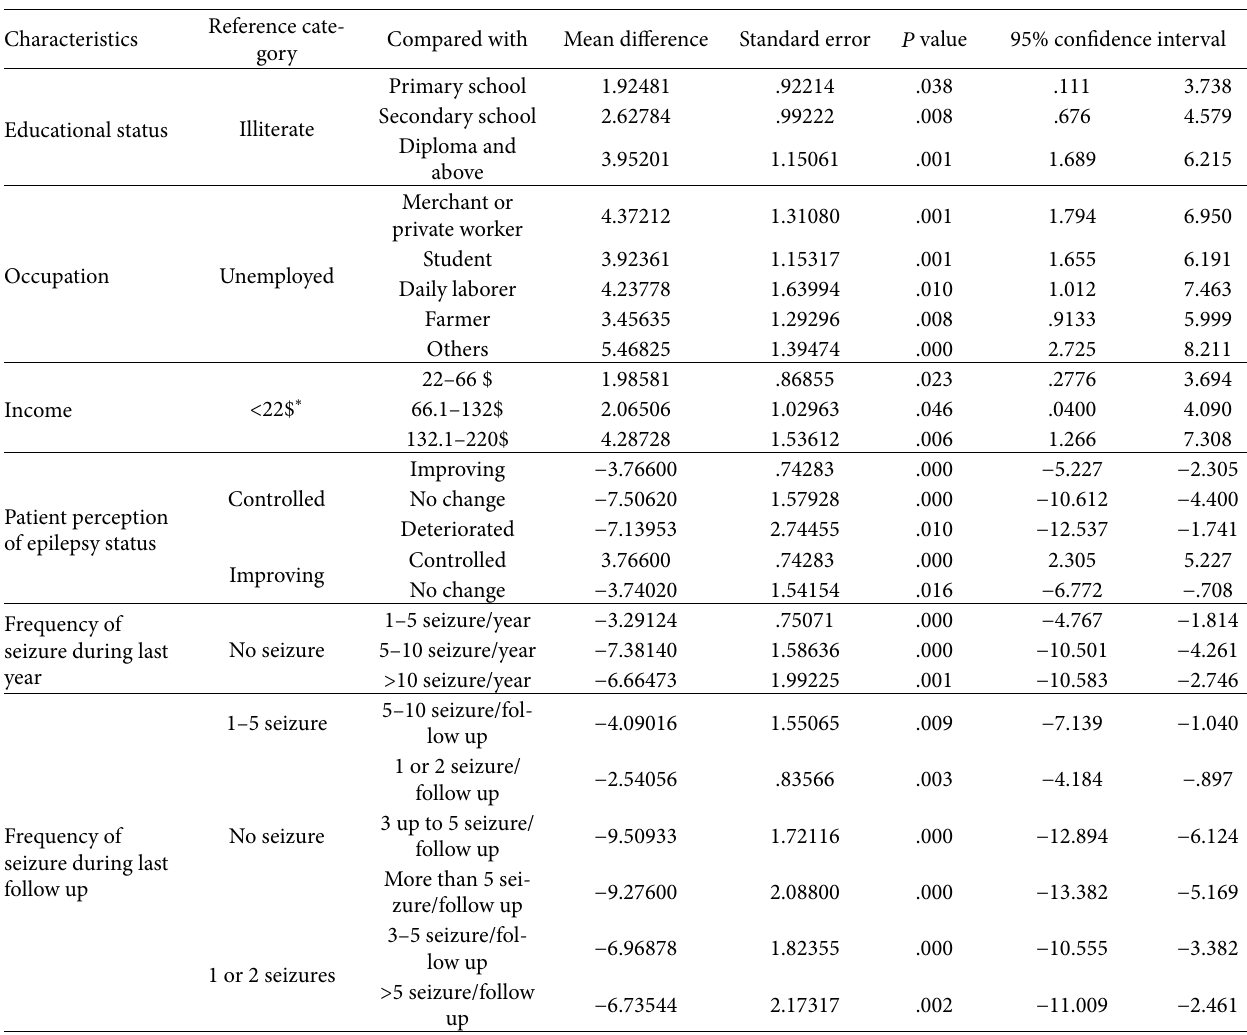
Table 5: Post-hoc analysis of demographic and clinical characteristics of patients which have significant association with quality of life in one way ANOVA, UoGRH, Northwest